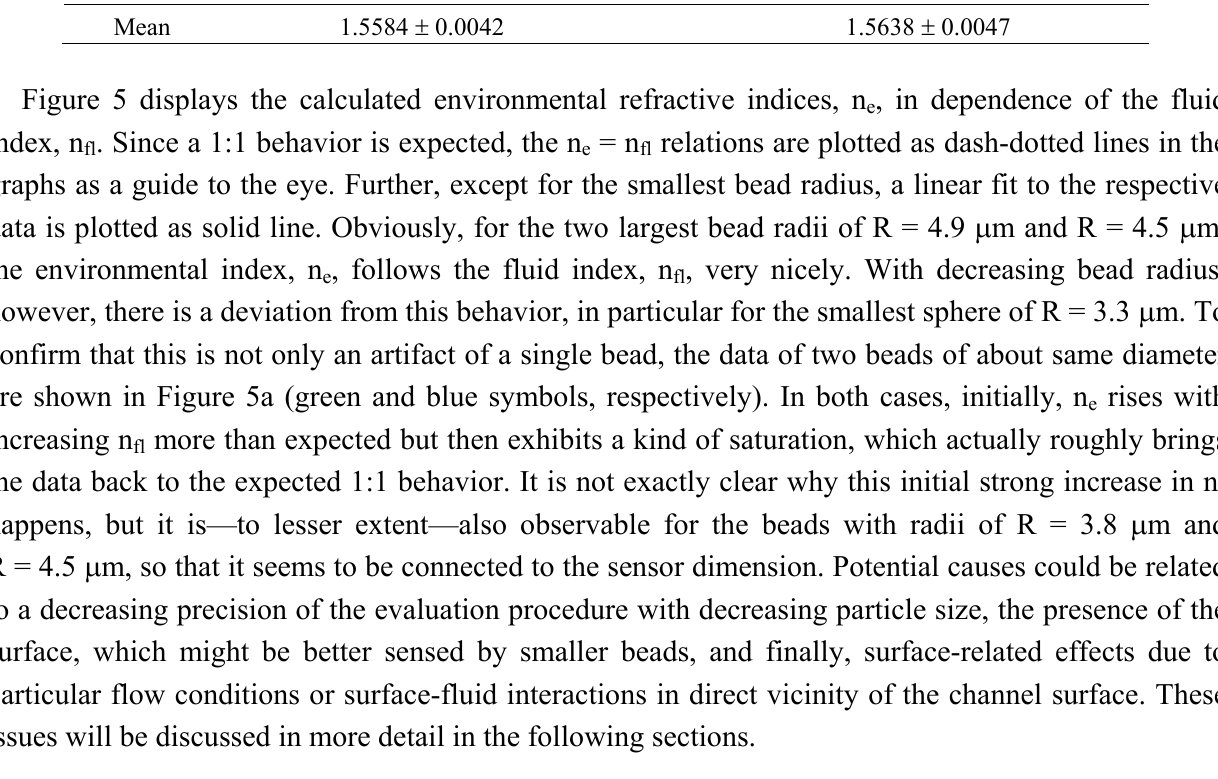
, as a function of bead radii for surface-adsorbed and s